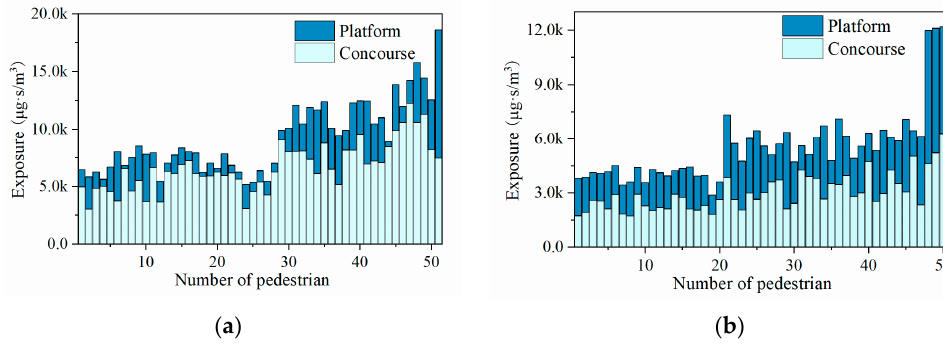
Figure 21. PM2.5 exposure calculation results: ( a ) Boarding; ( b ) Alighting.